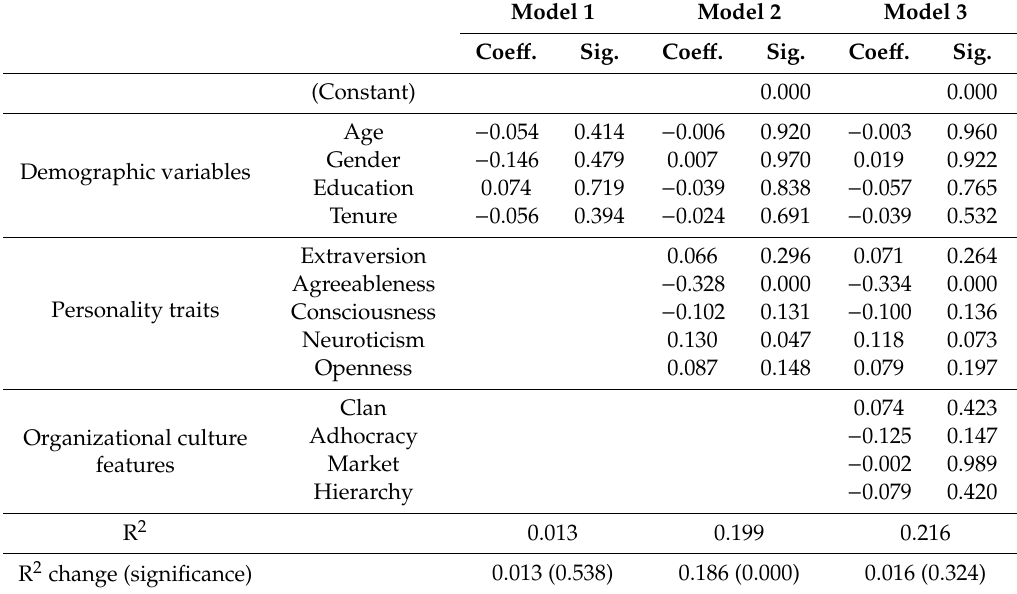
Table 3. Hierarchical linear regression results for interpersonal workplace deviant behavior and control variables, personality traits, and features of organizational